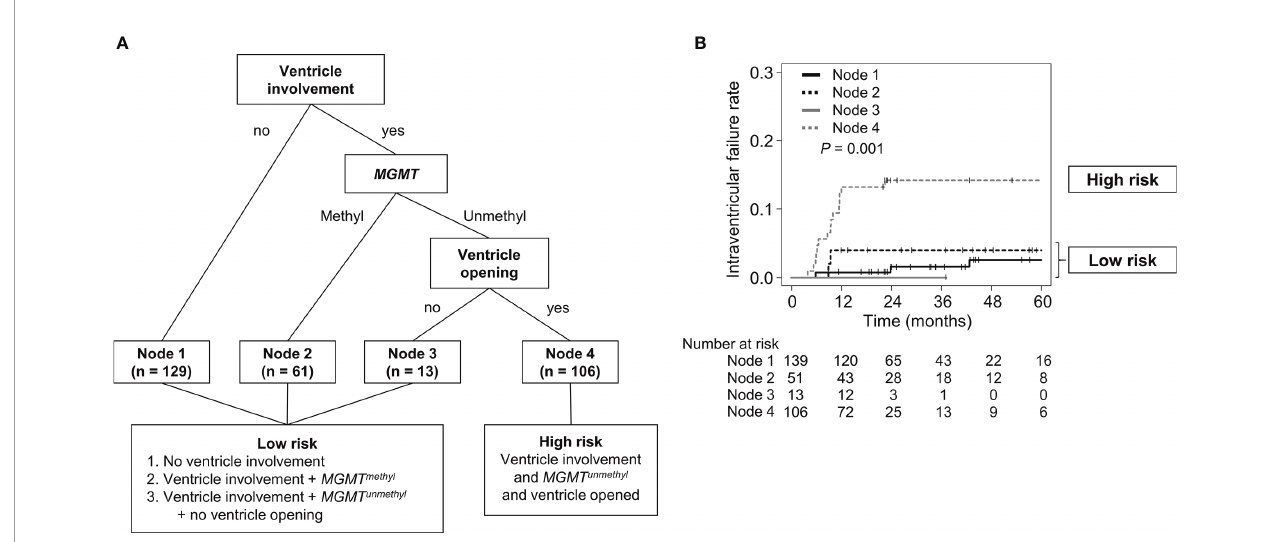
FIGURE 2 | RPA classi fi cation according to the risk of intraventricular seeding. (A) Diagram of RPA classi fi cation in patients who did not receive WVRT. (B) Intraventricular failure rates of the RPA-classi fi ed nodes. RPA, recursive partitioning analysis; WVRT, whole-ventricular